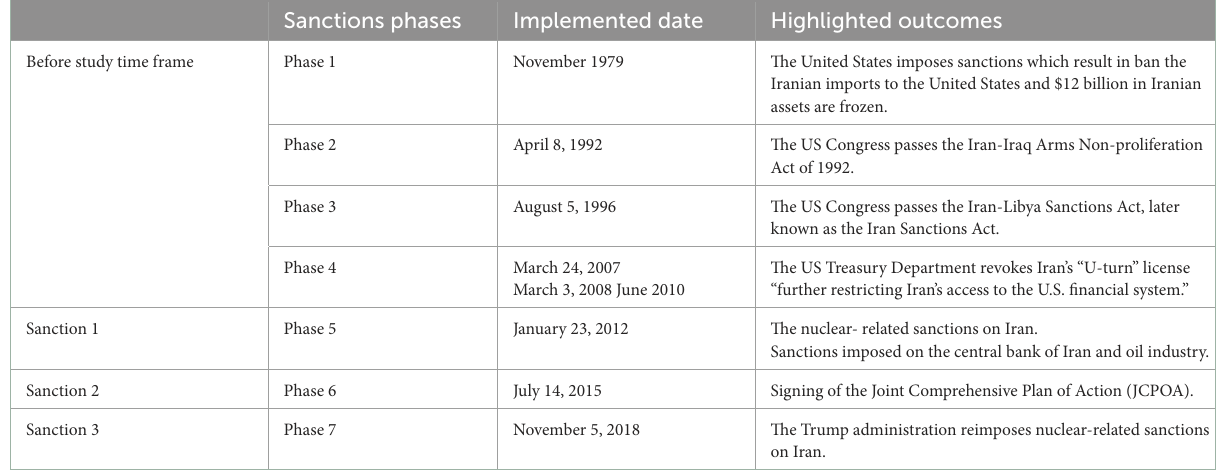
TABLE 1 The economic impact of the US sanctions on